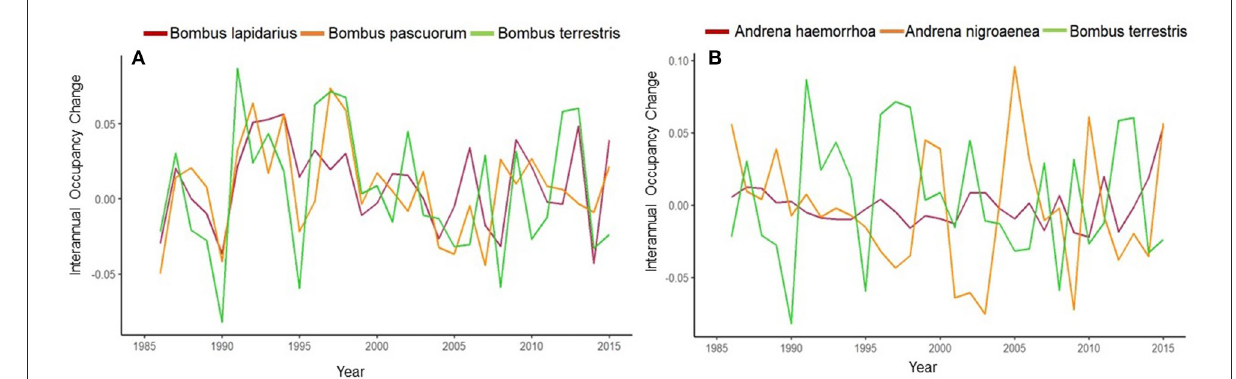
FIGURE2 Inter-annual occupancy changes for five bee species. Three Bombus species (A) have positively correlated occupancy dynamics ( Bombus lapidarius and Bombus pascuorum ( r = 0.57), Bombus lapidarius and Bombus terrestris ( r = 0.53), Bombus pascuorum and Bombus terrestris ( r = 0.44). Two Andrena species (B) have positively correlated occupancy dynamics ( r = 0.47), but have negatively correlated occupancy dynamics with Bombus terrestris ( Andrena haemorrhoa and Bombus terrestris ( r = − 0.31), Andrena nigroaenea and Bombus terrestris ( r = − 0.36).